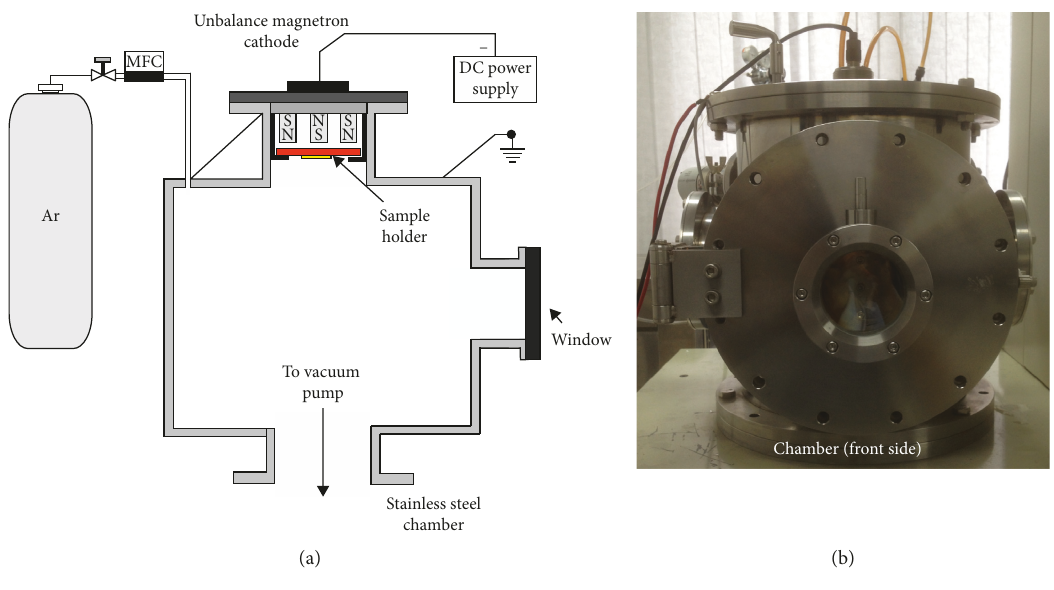
Figure 2: (a) Schematic illustration and (b) photograph of reactor chamber for plasma ion bombardment.